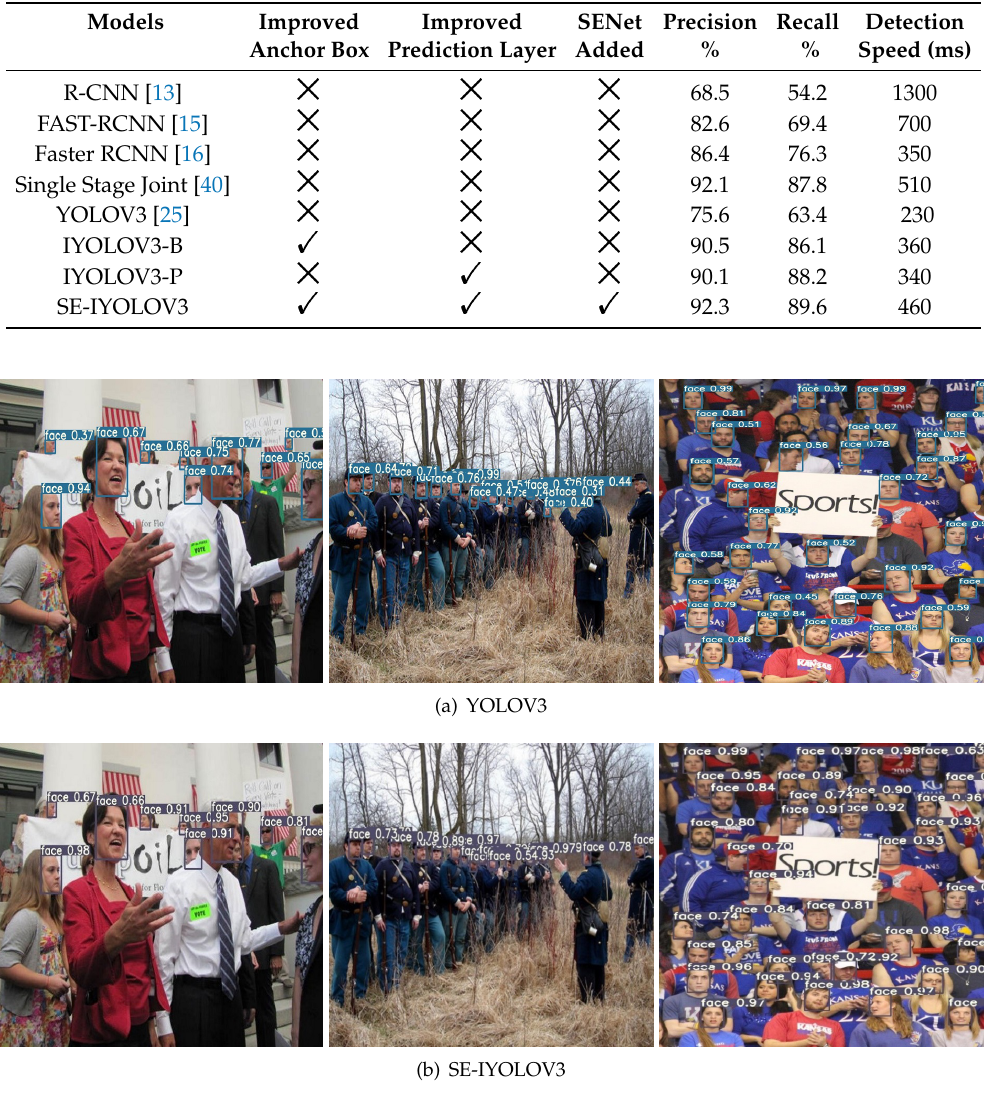
Table 3. Feature map information output from the SENet layer.